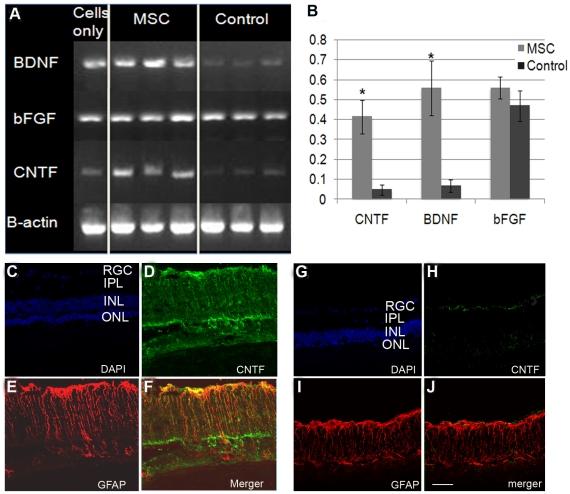
Upregulation of trophic factors.A. Semi-quantitative RT-PCR for CNTF, bFGF, BDNF and beta actin. Lane 1: RNA isolated from MSC prior to injection; Lane 2–4: RNA isolated from retinas treated with MSC; Lane 5–7: RNA isolated from non-treated control retinas. B. Densitometry analysis of CNTF, BDNF and bFGF in treated versus untreated samples. Beta actin was used to normalize the data for comparison. Level of CNTF and BDNF in the treated retinas were significantly higher than non-treated controls (p<0.05), while the level of bFGF in MSC treated retina did not increase significantly. C–J: confocal images of retinal sections double stained with antibodies to CNTF (green) and GFAP (red), counterstained with DAPI (blue in C and G) from MSC treated and controls. Strong CNTF staining in MSC treated retina (D) compared with untreated control (H); E&I: retinal sections stained with GFAP (red) showing upregulation of GFAP in Müller glia in both MSC treated and untreated control; F&J: merged images showing colocalization of CNTF and GFAP in MSC treated retina (F), which was not observed in untreated control (J) (Scale bar equals 50 µm).